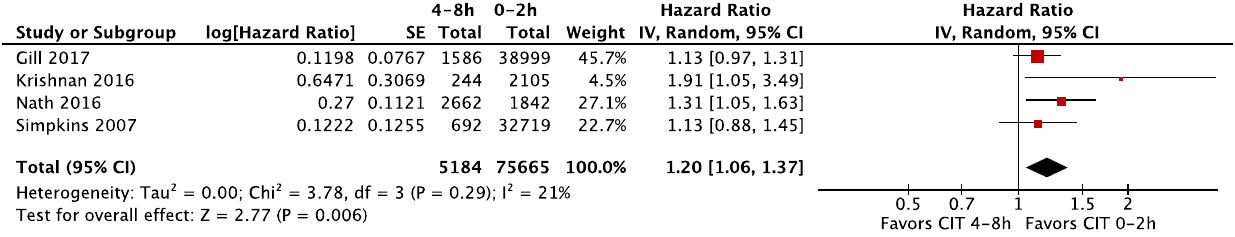
Figure 9. Five-year graft survival hazard ratio; CIT of 0–2 h versus 2–4 h. CIT: cold ischaemia time. Figure 10. Five-year graft survival hazard ratio; CIT of 0–2 h versus 4–8 h. CIT: cold ischaemia time.